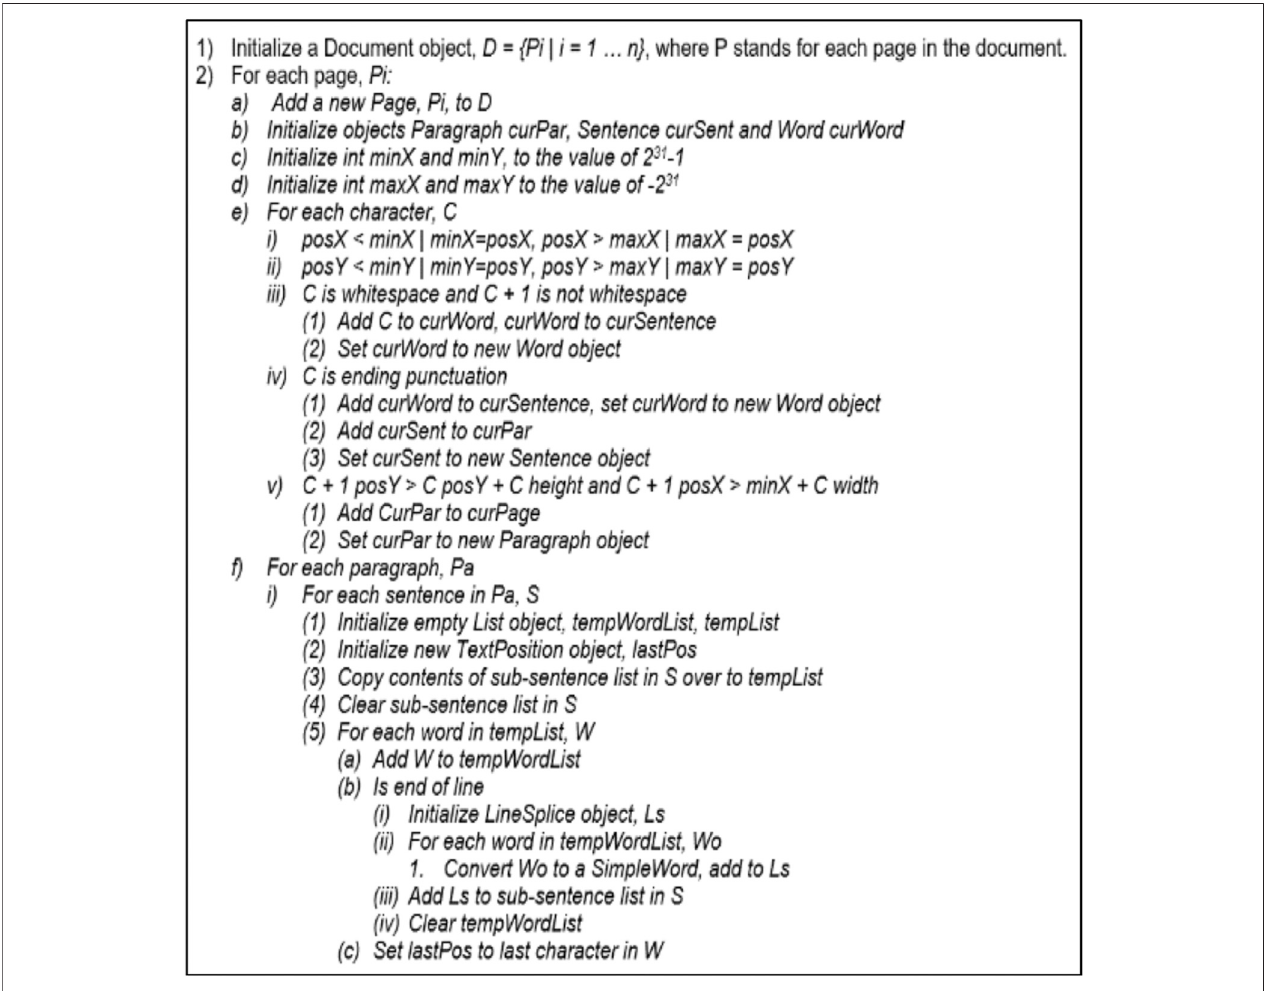
FIGURE 2 | The algorithm of extracting document